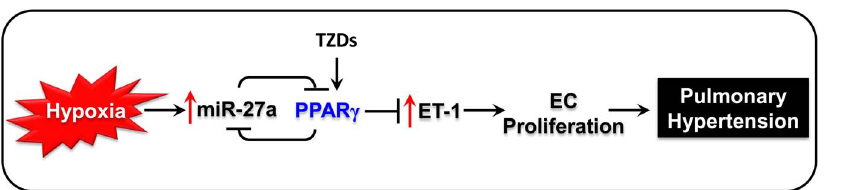
Figure 8. Putative pathways by which PPAR c and miR-27a regulate ET-1 in PH. The current findings indicate that hypoxia increases lungs miR-27a expression and that increases in miR-27a reduce PPAR c levels which stimulates increased ET-1 levels and pulmonary vascular cell proliferation. Conversely, activating PPAR c with rosiglitazone attenuated hypoxic upregulation of miR-27a and ET-1. These findings suggest that PPAR c ligands attenuate alterations in miR-27a and ET-1 levels to reduce